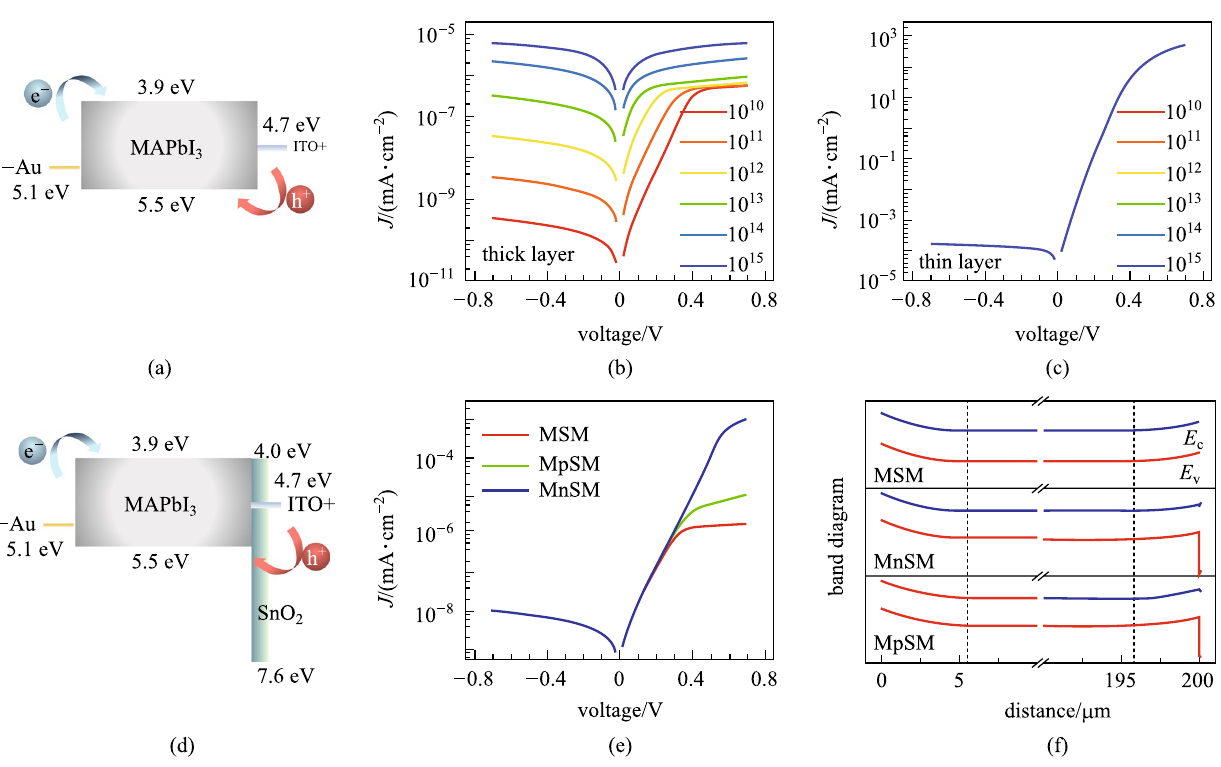
Fig. 3 Simulated structures and output performances of MAPbI 3 detectors. a, d Band diagram of MAPbI 3 devices with (a) the Schottky junc- tion and (d) the p–n junction. b , c are the simulated J – V curves of thick layer and thin layer devices based on the structure ( a ), with different deep defect concentrations. e Comparison between the simulated J – V characteristics with Schottky, n-type and p-type junction, where M denotes Au or ITO electrode, S denotes MAPbI 3 semiconductor, and n or p denotes n-type or p-type SnO 2 layer. f Simulated energy band of devices with Schottky, n-type and p-type